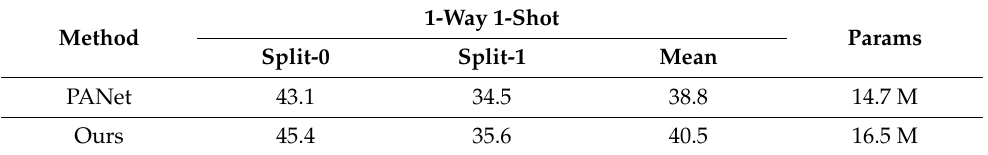
Table 2. Results of 1-way 1-shot segmentation on PDID-5 i dataset using mean-IoU